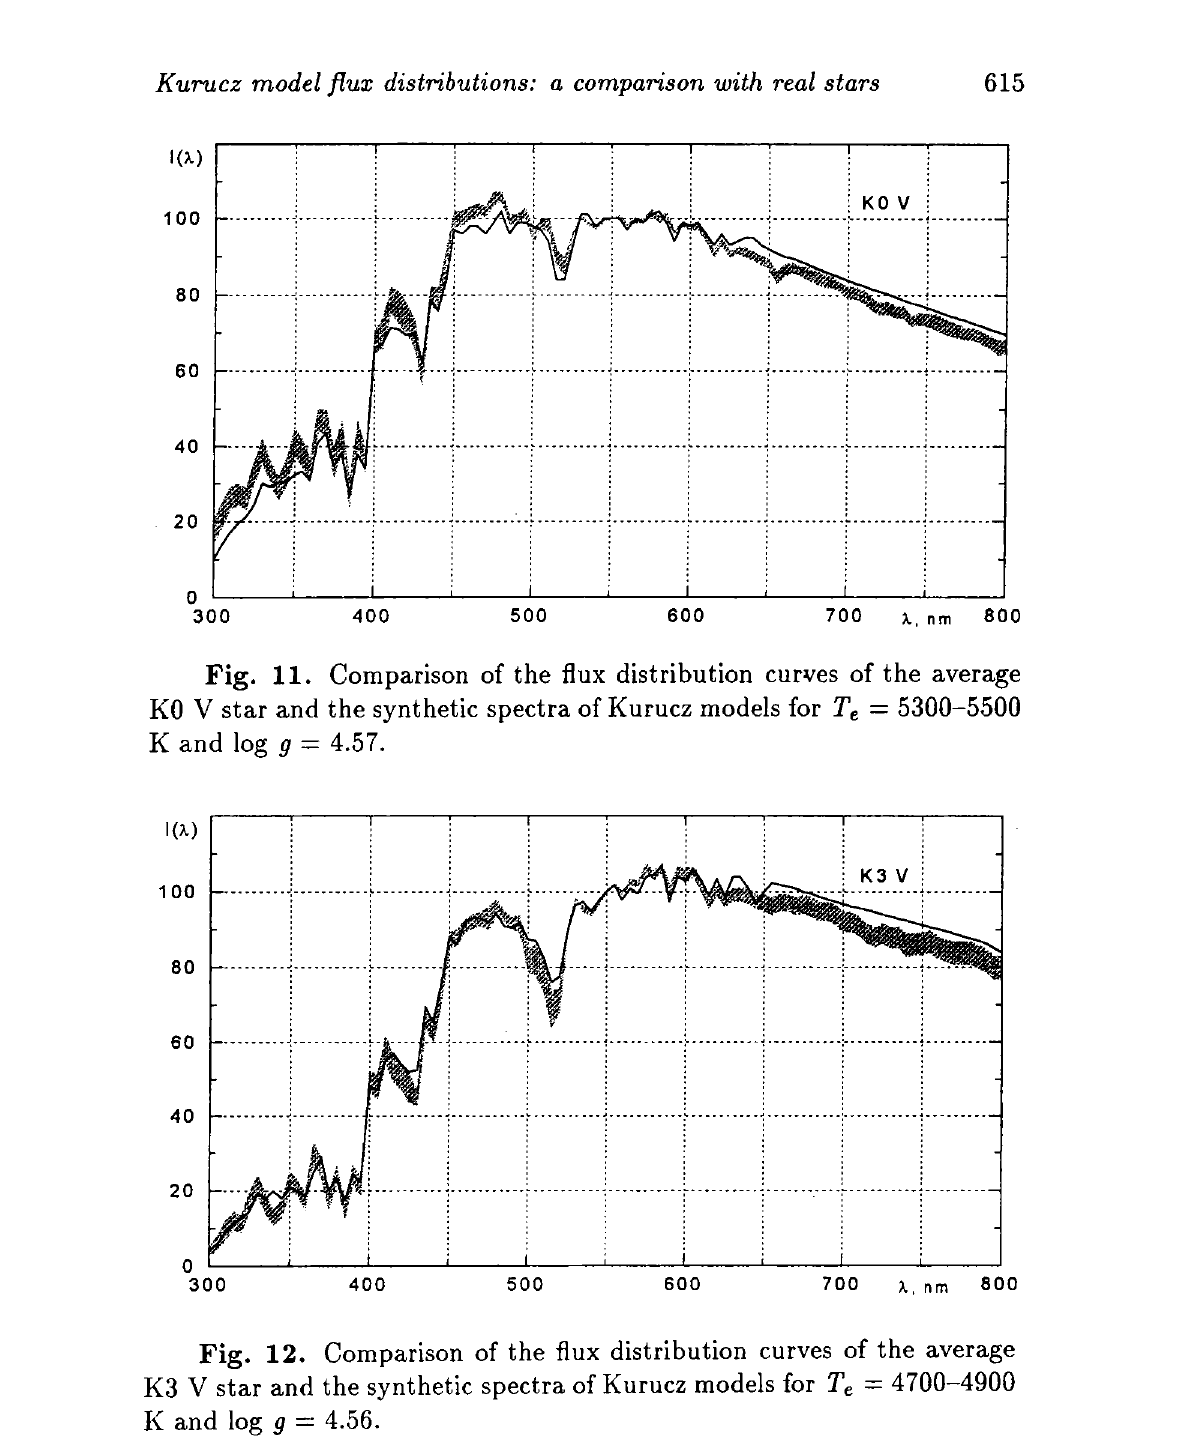
Fig. 12. Comparison of the flux distribution curves of the average K3 V star and the synthetic spectra of Kurucz models for T K and log g =